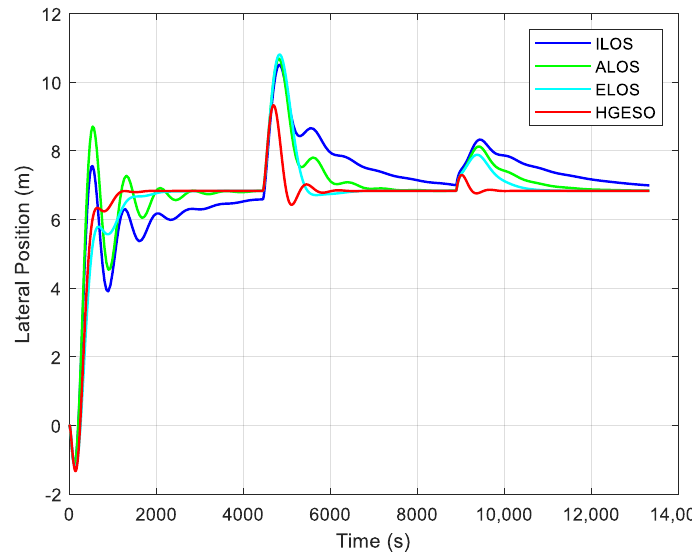
Figure 7. Comparison of lateral position with different guidance laws at y d = 0.05 L